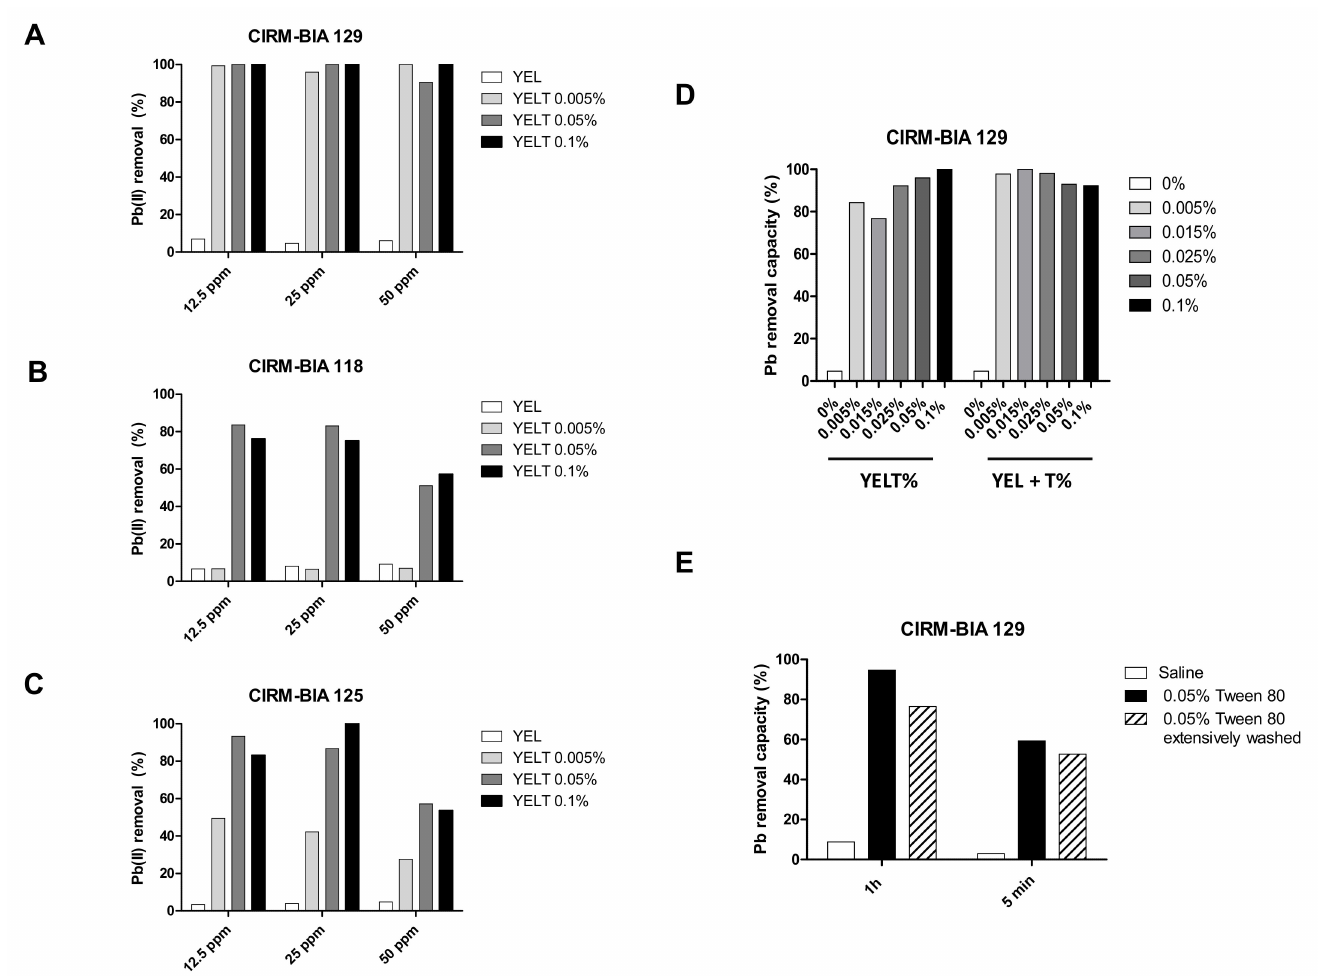
Figure 3. The Pb(II) removal ability of three P. freudenreichii strains as a function of the lead concentra- tion, Tween ® 80 concentration, and contact time. ( A ) strain CIRM-BIA 129, ( B ) strain CIRM-BIA 118, and ( C ) strain CIRM-BIA 125 were grown in YEL alone or in YEL medium containing 0.1% Tween ® 80 (YELT), prior to exposure to 12.5, 25, and 50 ppm Pb(II). ( D ) Comparison of various concentrations of Tween ® 80 added to the medium during culture or added at the same time as the metal ion solution, for P. freudenreichii CIRM-BIA 129. ( E ) Impact of the bacteria–0.05% Tween ® 80 contact time (1 h or 5 min) and extensive washing on CIRM-BIA 129’s ability to remove Pb 2+ . Representative data are expressed as the % of Pb 2+ removed from the